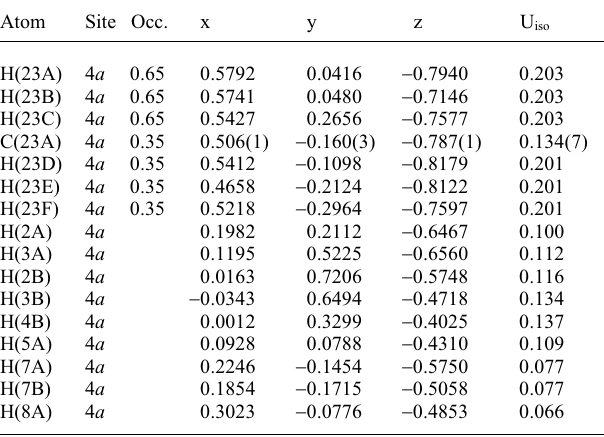
Table 2. Atomic coordinates and displacement parameters (in Å 2 )